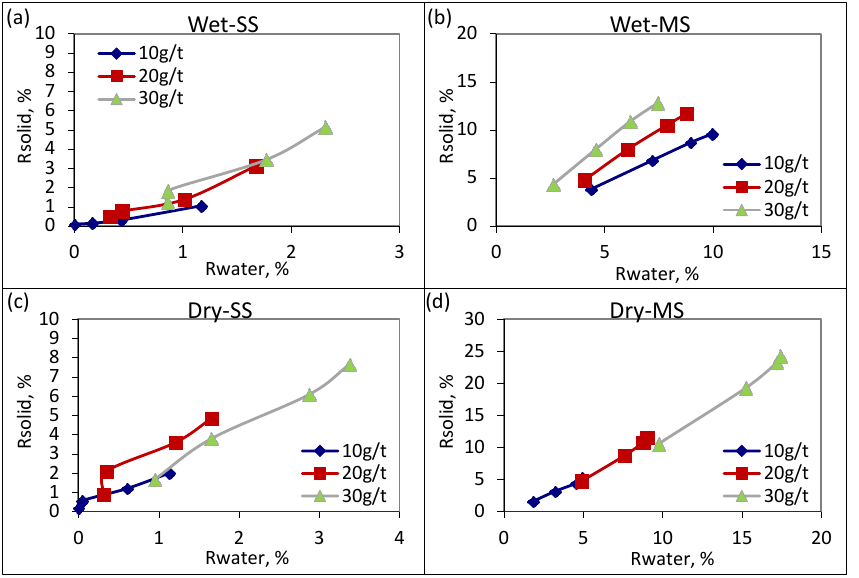
Figure 5. Solid vs. water recovery in flotation after milling conditions of ( a ) Wet-SS ( b ) Wet-MS ( c ) Dry-SS ( d ) Dry-MS.